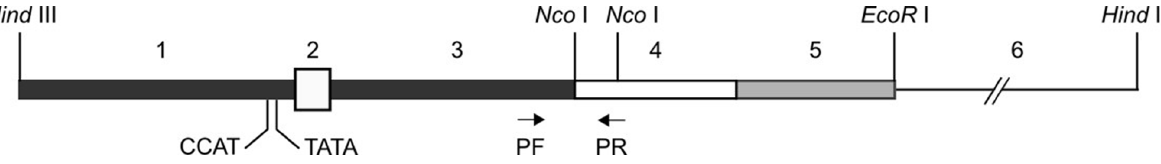
Figure 1. pCAgcGH structure diagram. 1: carp b -actin gene 5 9 -flanking sequence; 2: carp b -actin gene first exon; 3: carp b -actin gene first intron; 4: grass carp GH gene sequence; 5: grass carp GH gene 3 9 -flanking sequence; 6: plasmid pUC118. PF and PR indicate PCR primers of transgenes.